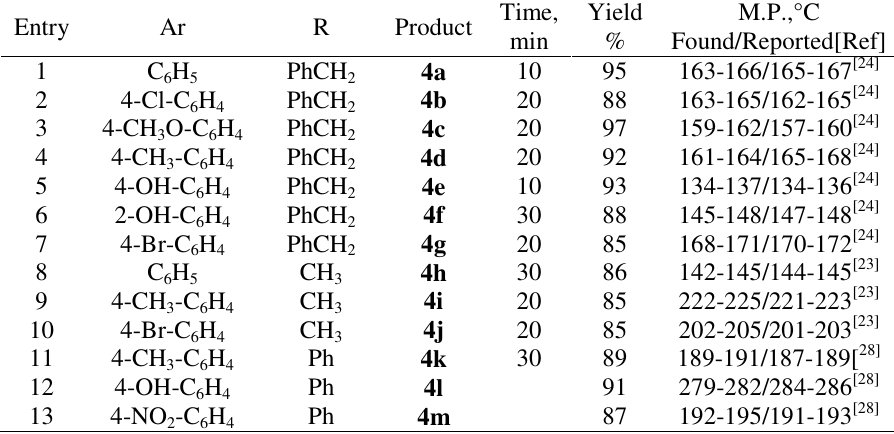
Table 3. Synthesis of 1,2,4,5-tetrasubstituted imidazoles using Preyssler acid as catalyst in refluxing